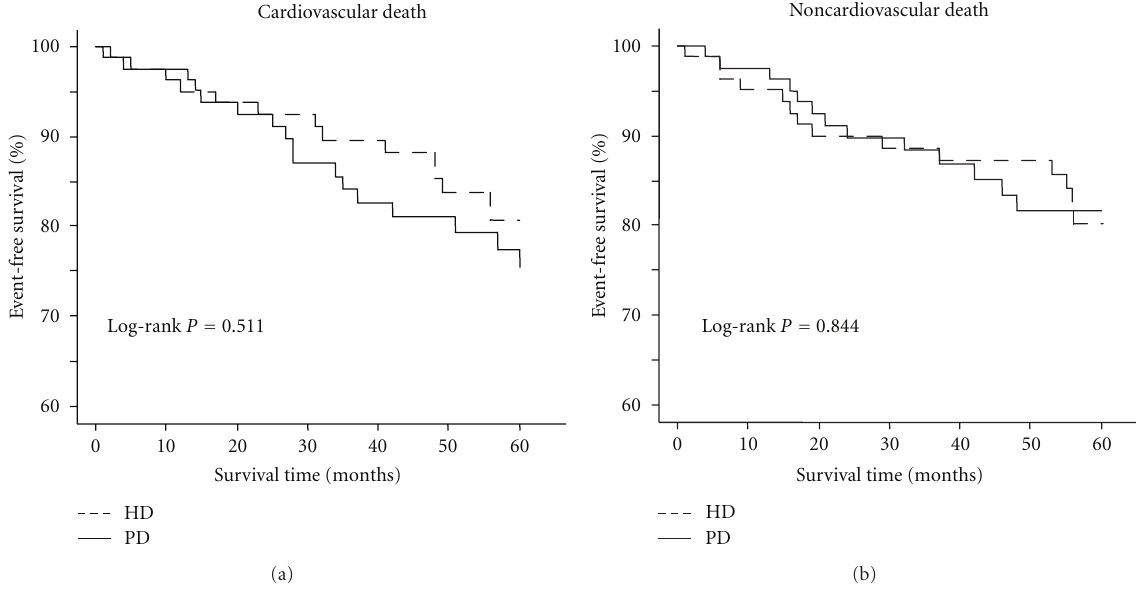
Figure 2: Cardiovascular and noncardiovascular mortalities by dialysis modality. PD: peritoneal dialysis; HD: hemodialysis.